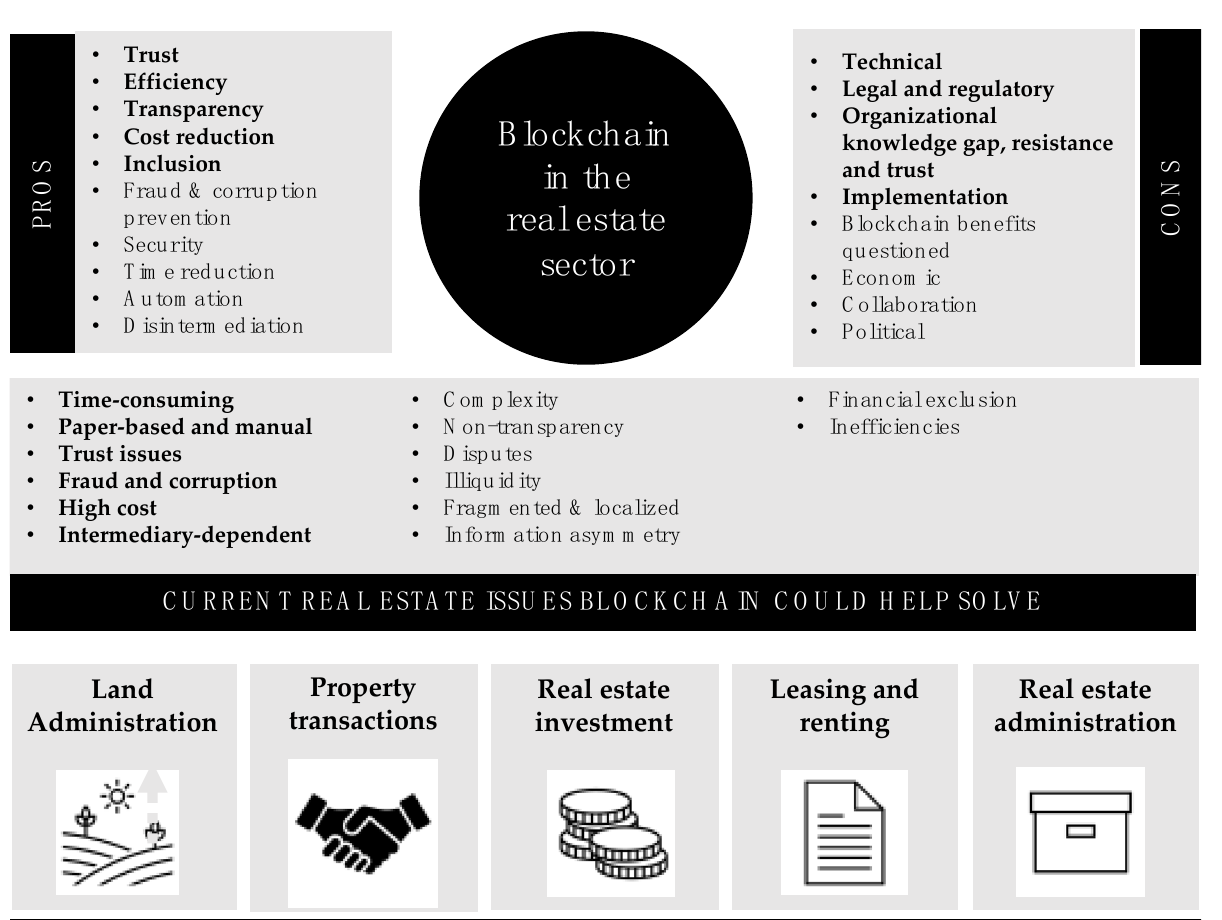
Figure 6. Blockchain’s grand promise for the real estate sector: the most attractive real estate subsectors for blockchain, current real estate issues, and blockchain pros and cons.